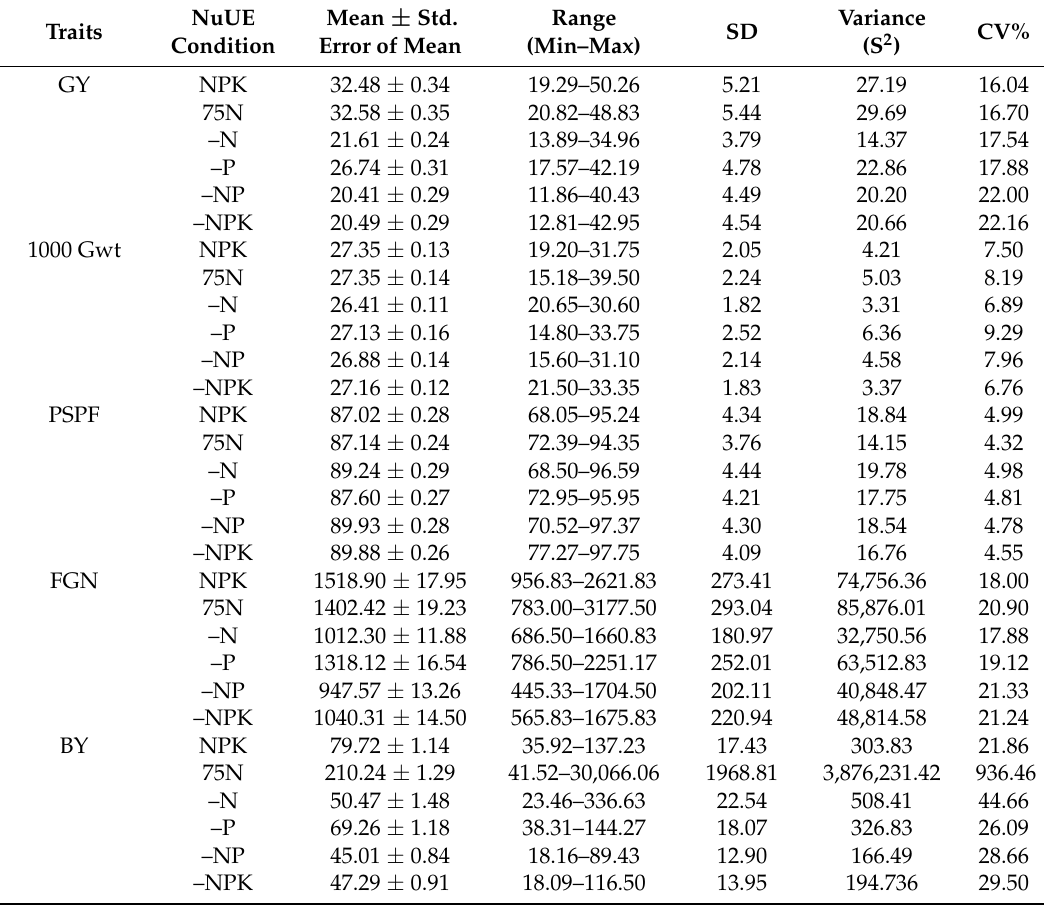
Table 1. Statistical description of nutrient use efficiency-introgression lines for critical traits under six NPK